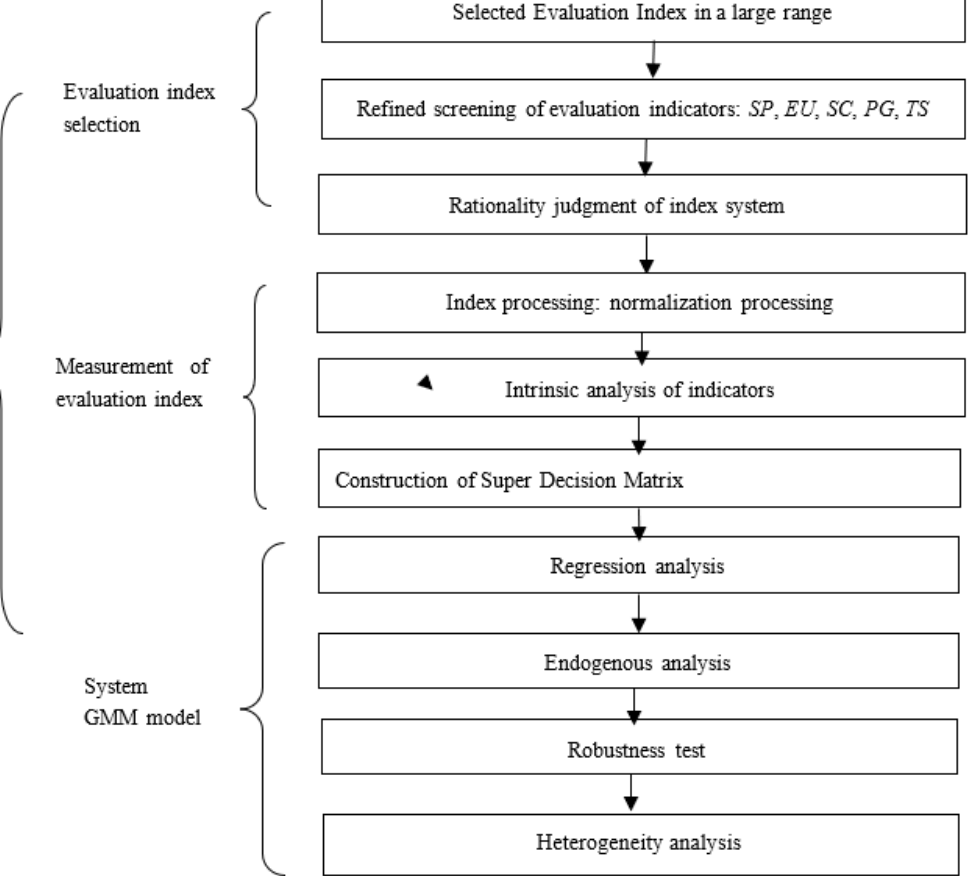
The information content of the index is solved by the coefficient of variation, and the index with the largest information content in the same category is selected to ensure that the selected index has a significant impact on the decarbonization of the power industry. The coefficient of variation of the index reflects the identification ability of the index in the decarbonization evaluation of the power industry. The greater the coefficient of variation is, the greater the distribution variability of the index in the evaluation of decarbonization